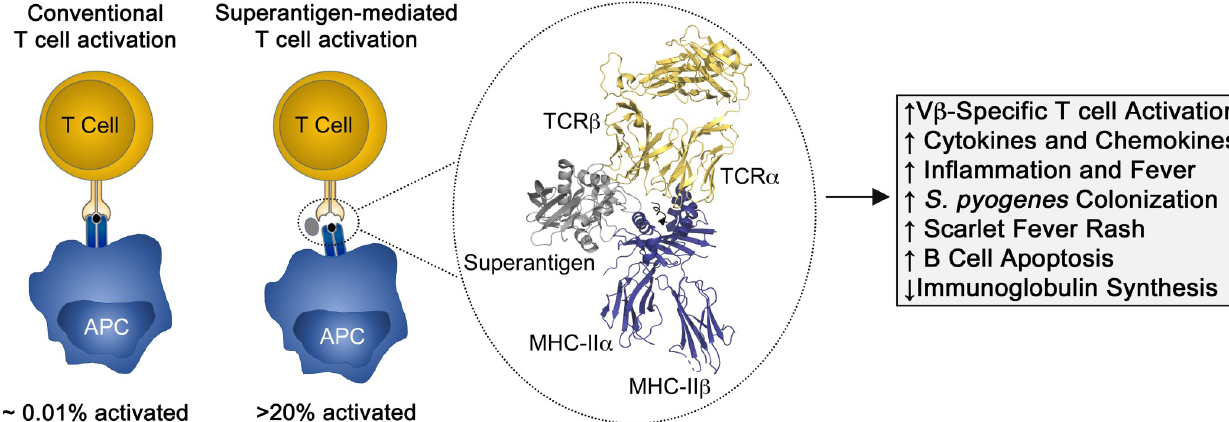
Fig 1. Overview of T cell activation by streptococcal superantigens and functional outcomes. Displayed are cartoons showing a comparison of conventional versus superantigen-mediated T cell activation, and a ribbon diagram of the SpeA superantigen (gray) in complex with the TCR expressed on a T cell (yellow) and MHC-II expressed on an APC (blue). Compared with convention T cell activation, note how the superantigen engages the β -chain of the TCR and displaces the TCR away from the MHC-II presented antigenic peptide (black) leading to the V β -specific activation of T cells. The structural model was generated using the co-crystal structure of SpeA in complex with mouse V β 8 (PDB code 1L0Y) and superimposing a human αβ TCR (PDB code 1FYT) and human MHC-II from the staphylococcal enterotoxin C3 superantigen in complex with HLA-DR1 (PDB code 1JWM). The ribbon diagram was generated using PyMOL Molecular Graphics System (https://pymol.org). APC AU : AnabbreviationlisthasbeencompiledforthoseusedinFig 1 : Pleaseverifythatallentriesarecorrect : , antigen presenting cell; MHC-II, MHC class II molecule; TCR, T cell receptor.